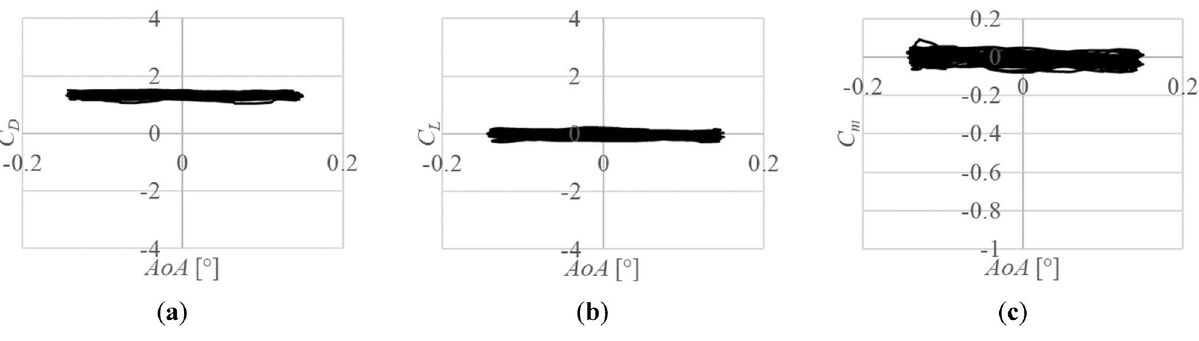
Figure 11. Aerodynamic coefficients of a vibrating javelin at the time-averaged AoA of 0° for one second: ( a ) Drag coefficient, C D ; ( b ) Lift coefficient, C L ; ( c ) Pitching moment coefficient, C m .